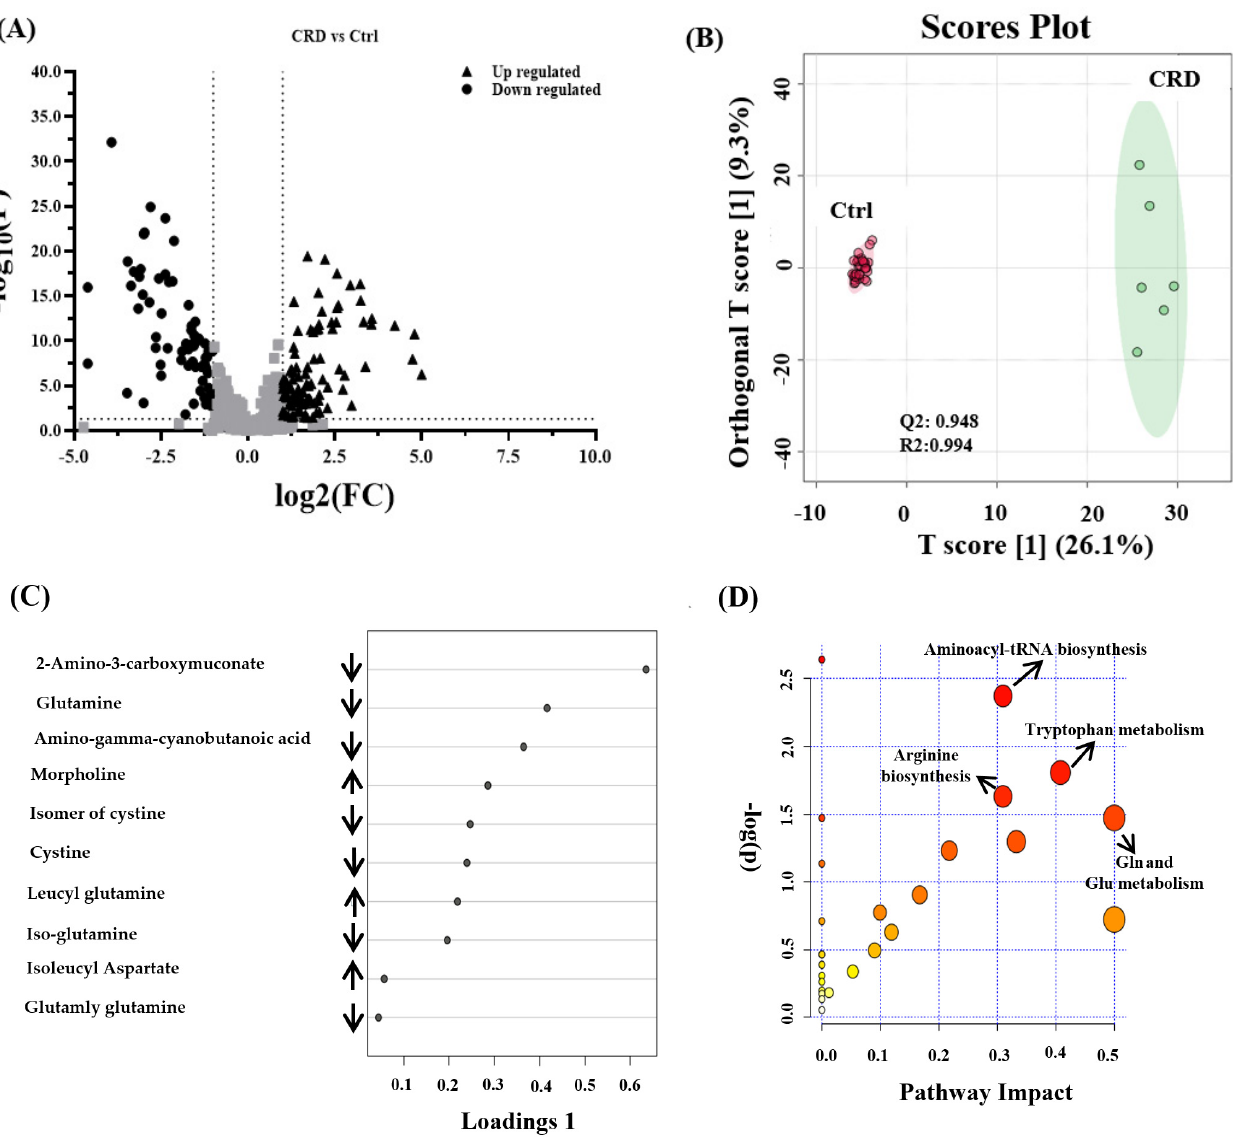
Figure 3. Binary comparison and pathway analysis and in the serum of patients with cystic renal diseases. ( A ) A Volcano plot analysis with fold change > 2 (up-regulated (n = 106), down-regulated (n = 70)) ( B ) Orthogonal partial least square discriminant analysis (OPLS-DA) score plot shows clear separation due to the biological differences between patients with CRD (n = 6) and Ctrl groups (n = 33) (R2 = 0.994 and Q2 = 0.948), that represents the level of global metabolic differential expression. ( C ) The loading plot shows the regulation of metabolic expression of metabolites in CRD compared to the Ctrl group. ( D ) Pathway analysis shows significantly altered pathways of Aminoacyl-tRNA biosynthesis and some amino acid metabolism pathways. (color-coded and the circle’s size reflect the combination between the p -value and the pathway impact, respectively).